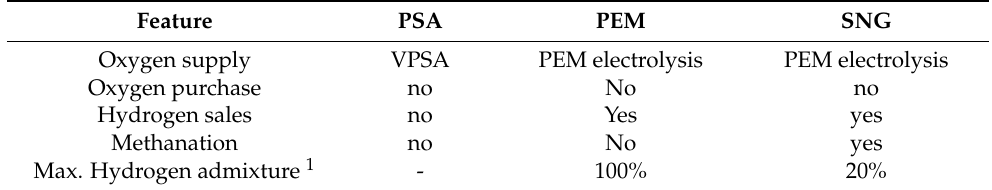
Table 1. Summary of the investigated